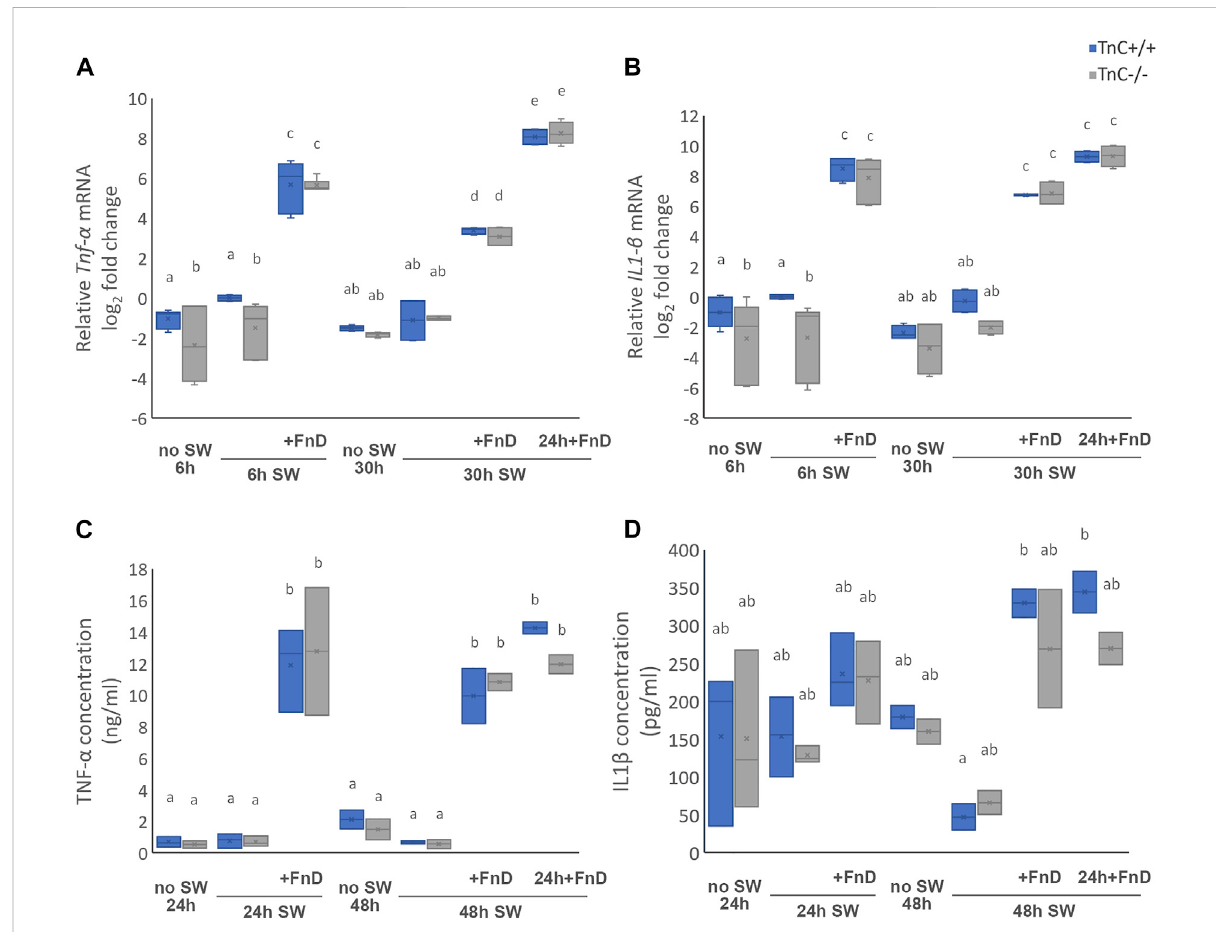
FIGURE 5 FnD treatment upregulates levels of pro-in fl ammatory cytokines TNF- α and IL-1 β . Relative Tnfa mRNA log2 fold change (A) and relative IL1b mRNA log2 fold change (B) are shown as box-whisker plots. Concentrations of cytokines released into the medium are shown as box-whisker plots for TNF- α (C) and IL-1 β (D) . Two-way ANOVA was used to test statistical signi fi cance. Pairwise comparisons are denoted with letters, shared letters imply no signi fi cant difference between groups. Actual p values are indicated in the text (n = 3 independent cultures, performed in